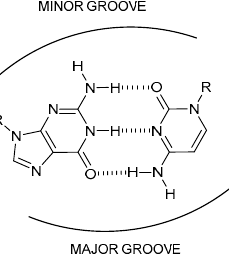
Figure 2. Major and minor groove sides of a G:C Watson-Crick base pair.